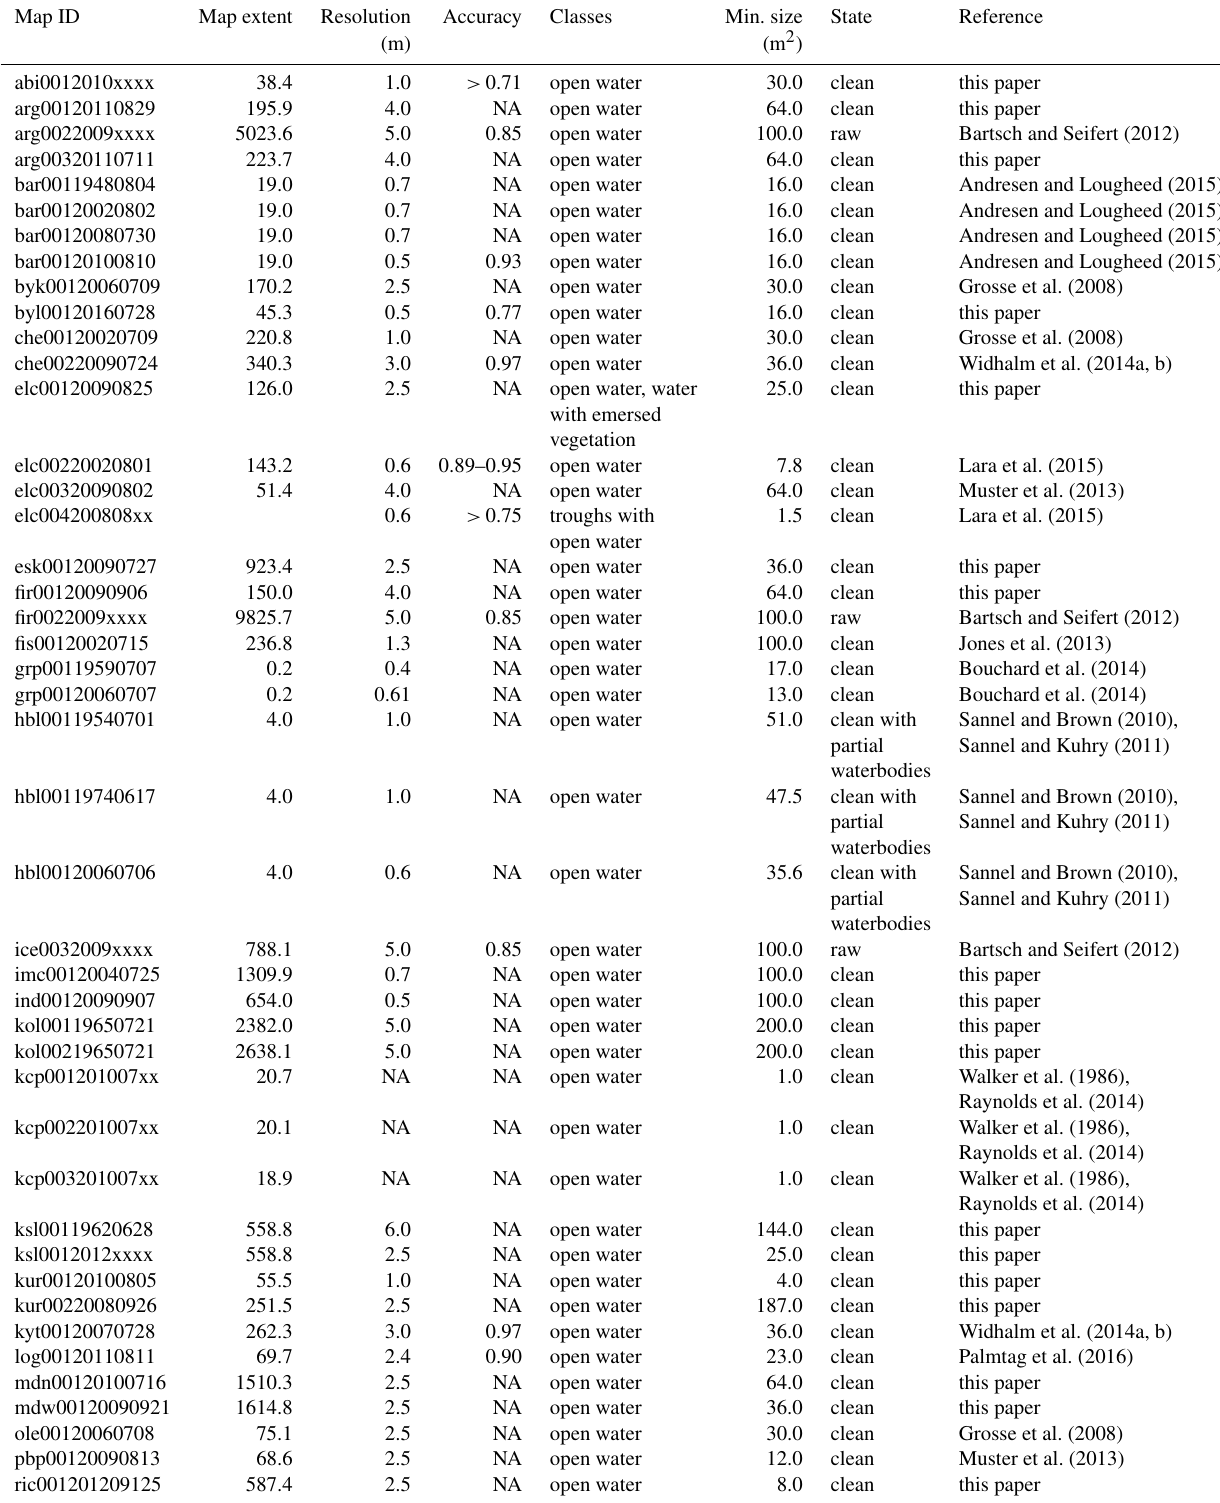
Table 1. Characteristics of waterbody maps. A “clean” map state indicates that the map only includes ponds or lakes. A “raw” map state indi- cates that no manual editing was conducted and that the map may contain rivers, streams, partial waterbodies, or cloud shadows. References indicate whether the map has already been published or was produced specifically for